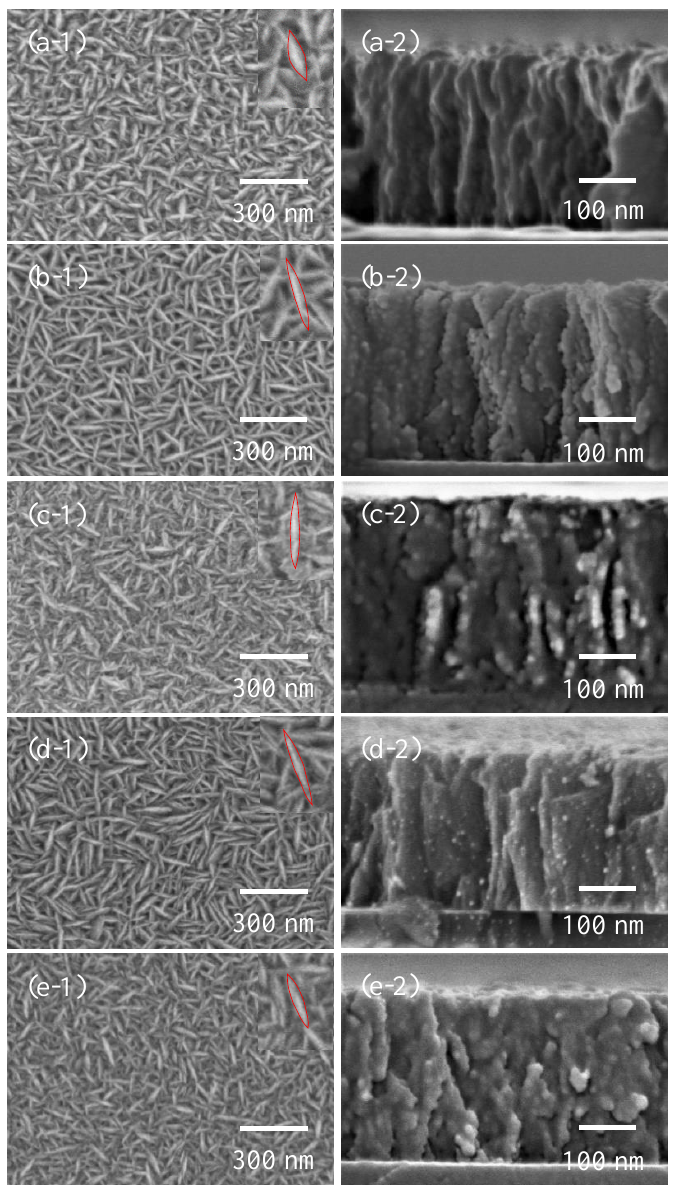
Figure 6. Scanning electron microscopy (SEM) images of TiO 2 films deposited with different TTIP concentrations by mist CVD method. (( a ) 0.05 mol/L; ( b ) 0.10 mol/L; ( c ) 0.20 mol/L; ( d ) 0.30 mol/L; ( e ) 0.40 mol/L; ( 1 ) top view; ( 2 ) cross section view).